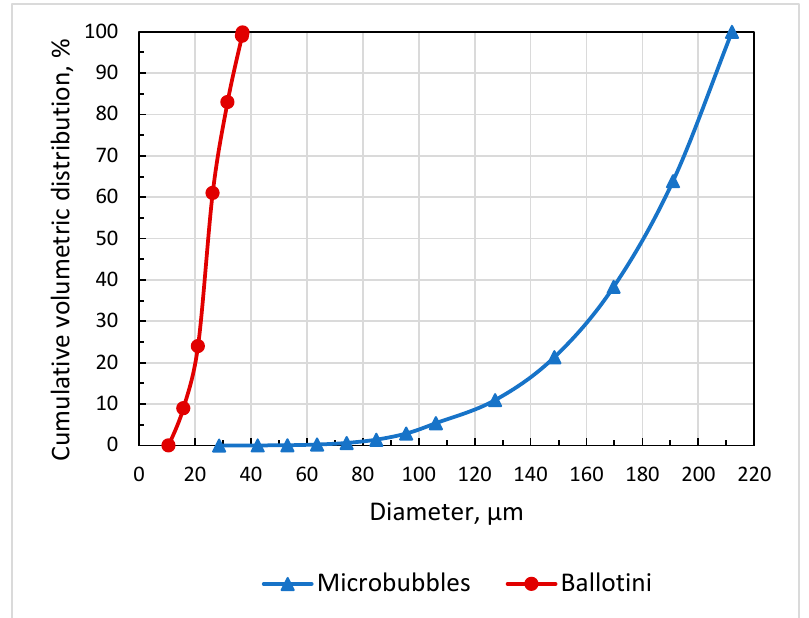
Figure 3. Cumulative volumetric distribution functions of ballotini and microbubbles.